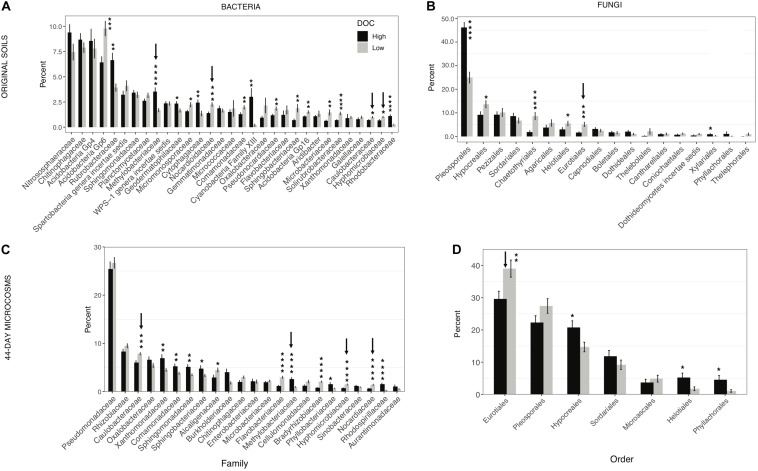
Microbial community composition in high and low dissolved organic carbon (DOC) microcosms. The mean proportion of sequences obtained (±SEM) for each phylogenetic group in the high and low DOC cohorts is shown. (A) Bacterial families and (B) fungal orders in original soils. (C,D) Bacterial families and fungal orders in 44-day microcosms. Only families and orders with a minimum mean relative abundance of 1% in at least one of the DOC cohorts are shown. Statistically significant differences were determined by two tailed t-tests (*P < 0.05, **P < 0.01, ***P < 0.001, ****P < 0.0001). Arrows indicate taxa with consistent significant differences between the high and low DOC cohorts with both the original soil data and the 44-day microcosm data.